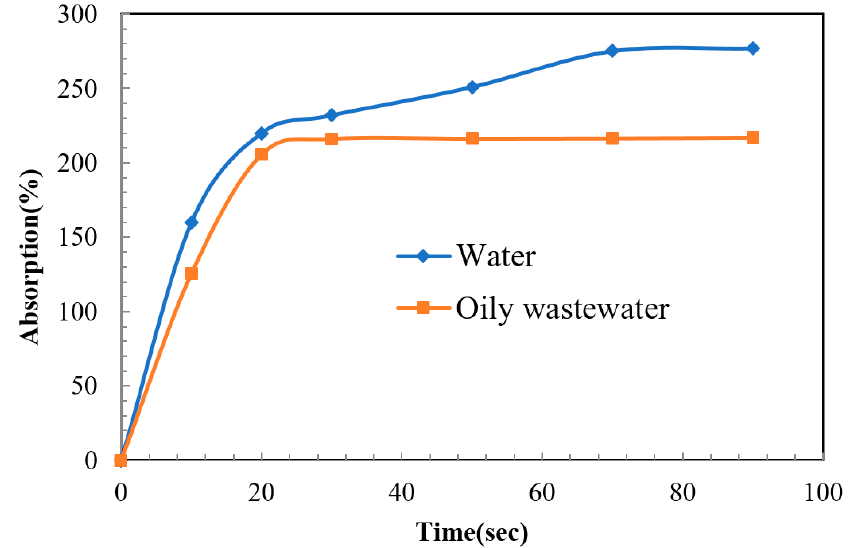
Figure 9. Water and oily wastewater absorption of the thin film composite membrane.